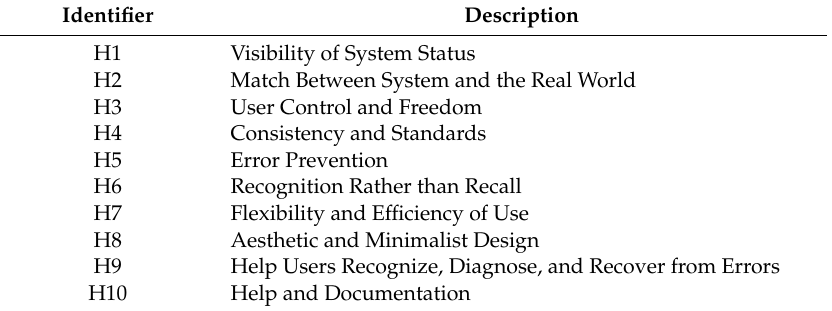
Table 3. Nielsen’s Usability Heuristics, based on Nielsen